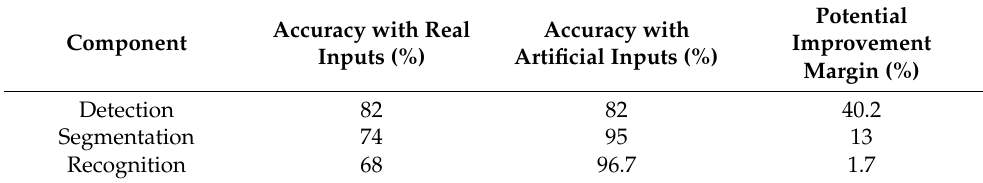
Table 1. Summary performance comparisons for both actual and artificial inputs for the ALPR system under study. As expected, the artificial inputs used in this analysis resulted in a significant potential for performance improvement as compared to that of the original